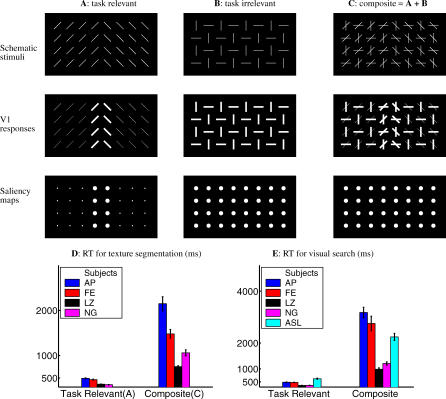
Prediction of Interference by Task-Irrelevant Features, and Its Psychophysical Test(A–C) Schematics of texture stimuli (extending continuously in all directions beyond the portions shown), each followed by schematic illustrations of its V1 responses, in which the orientation and thickness of a bar denote the preferred orientation and response level, respectively, of the activated neuron. Each V1 response pattern is followed below by a saliency map, in which the size of a disk, denoting saliency, corresponds to the response of the most activated neuron at the texture element location. The orientation contrasts at the texture border in (A) and everywhere in (B) lead to less suppressed responses to the stimulus bars since these bars have fewer iso-orientation neighbours to evoke iso-orientation suppression. The composite stimulus (C), made by superposing (A) and (B), is predicted to be difficult to segment, since the task-irrelevant features from (B) interfere with the task-relevant features from (A), giving no saliency highlights to the texture border.(D,E) RTs (differently colored data points denote different subjects) for texture segmentation and visual search tasks testing the prediction. For each subject, RT for the composite condition is significantly higher (p < 0.001). In all experiments in this paper, stimuli consist of 22 rows × 30 columns of items (of single or double bars) on a regular grid with unit distance 1.6° of visual angle.